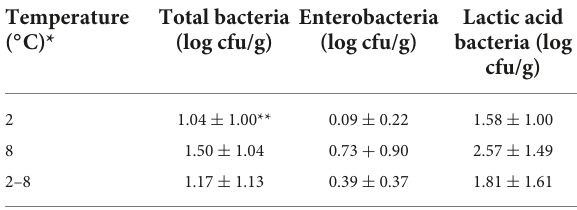
(B) at the end of the production